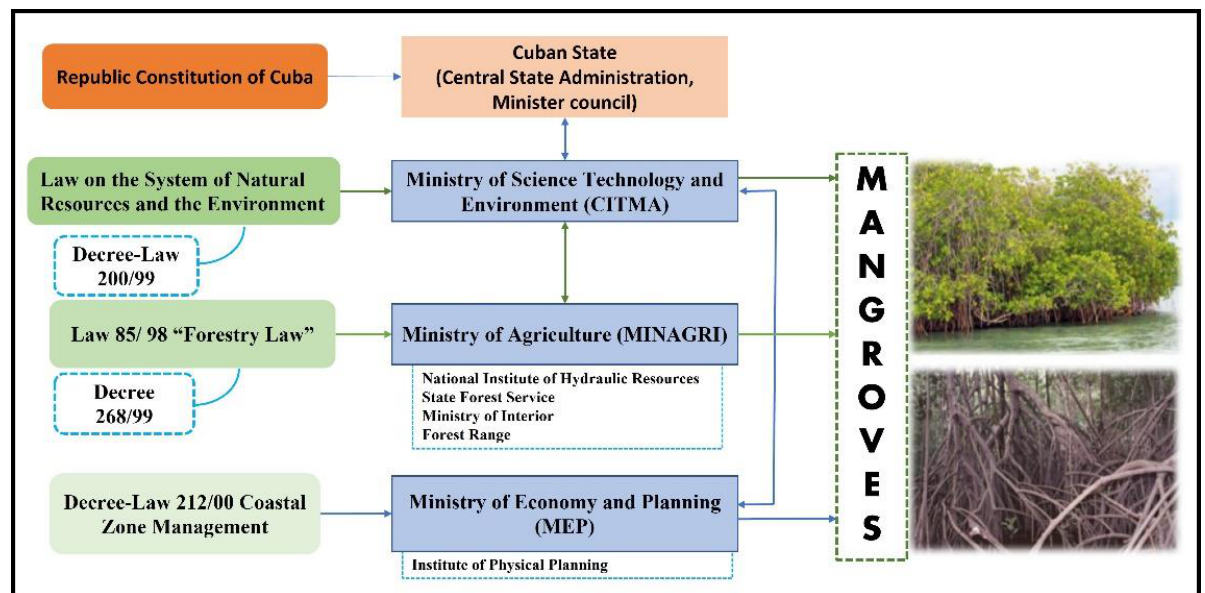
Figure 2. Scheme of competencies established in the legal framework in force in